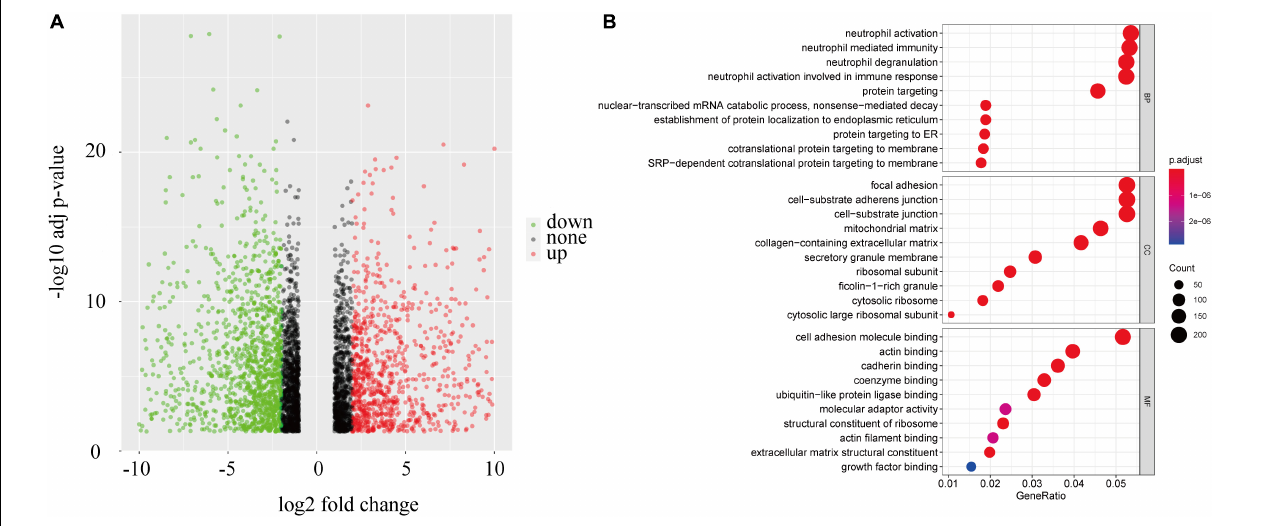
FIGURE 8 | Enrichment in patients with different risks. (A) A volcano plot of genes in ccRCC patients with low and high risk scores. (B) Functional annotation of the DEGs based on gene ontology